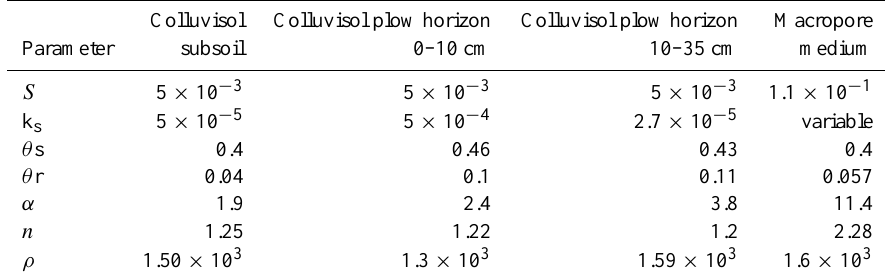
Table 1. Soil hydraulic Mualem-van Genuchten parameters determined by Sch¨afer (1999). S : specific storage coefficient of the soil [-], k s : saturated hydraulic conductivity [m s − 1 ], θ s : saturated vol. soil moisture [-], θ r : residual vol. soil moisture [-], α : van Genuchten’s α [m − 1 ],